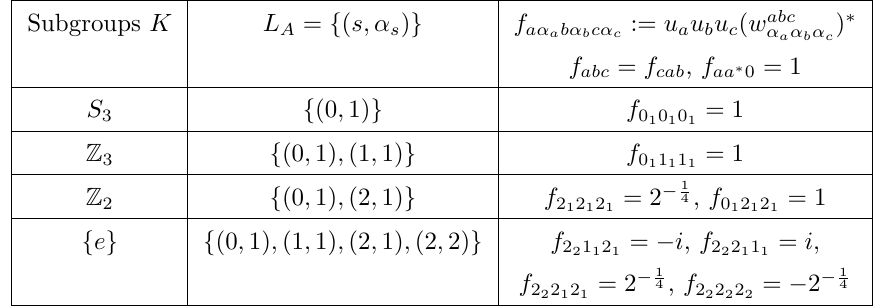
= ( L A ; f ) S of the Fourier-transformed ex- 3 ;K 3 ;K